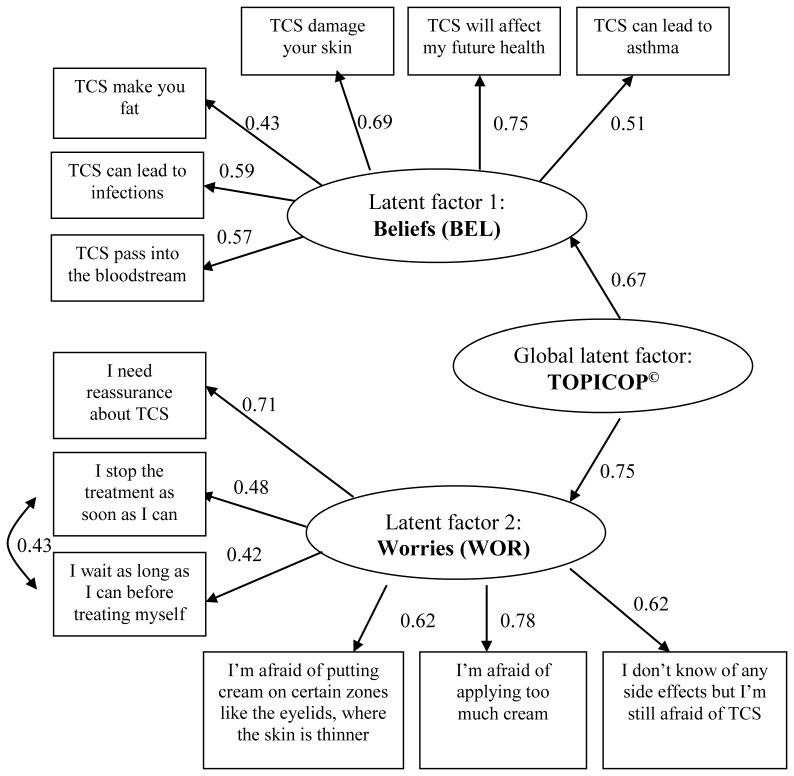
Structural equation model of the TOPICOP© scale.Abbreviation: TCS, topical corticosteroids. Goodness-of-fit criteria: Steiger’s root mean square error of approximation = 0.005; Bentler and Bonnet’s normed fit index = 0.89; Goodness-of-fit index = 0.94.